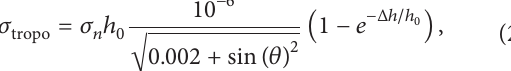
Table 1: Conservative (right) and optimistic models for 𝜎